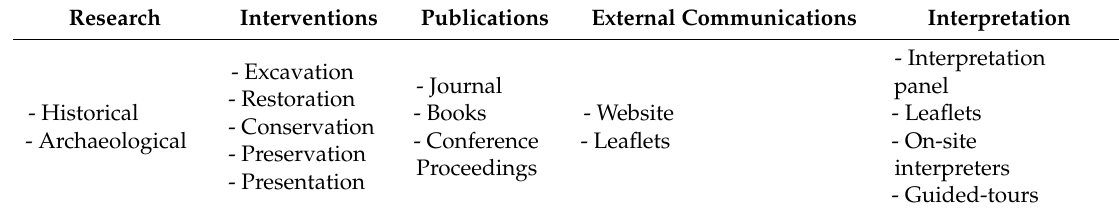
Table 1. Heritagization strategies of the municipality associated with the